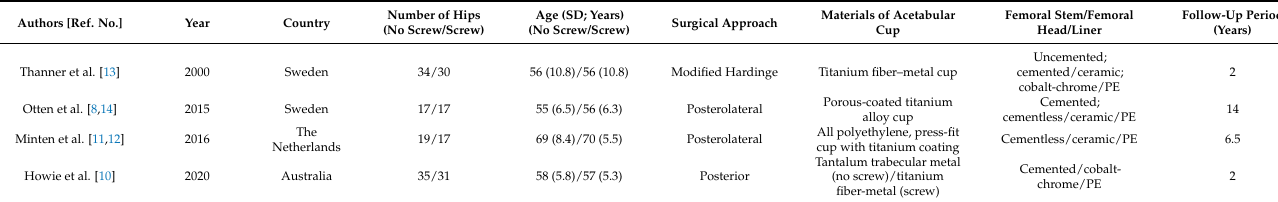
Table 1. Characteristics of included studies.